Question: Summarize what this figure shows in one sentence.
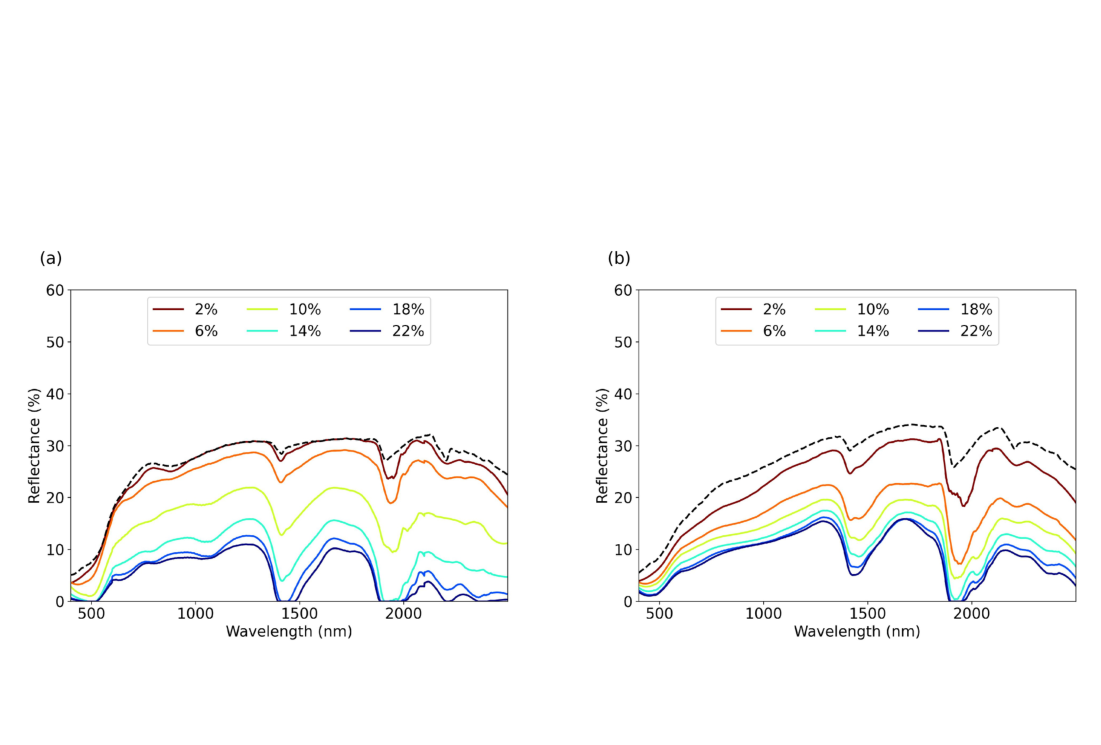
Answer: Wet soil reflectance spectra predicted by the wet soil spectra model based on dry soil spectra (black dotted lines) randomly generated by the SOGM. The values in the figure legends are the input soil moisture content (%).